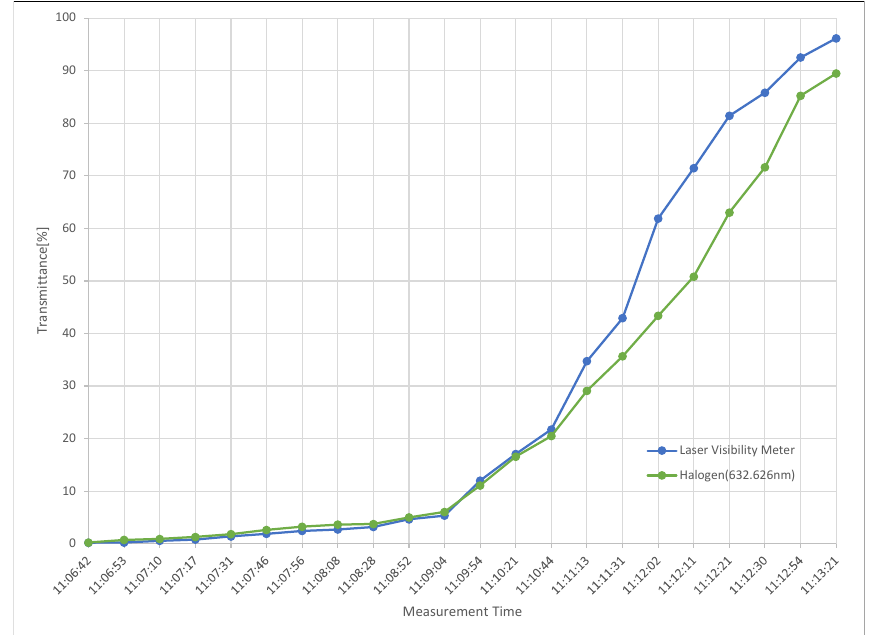
Figure 10. The measured transmittance obtained in the halogen transmittance experiment at 632.8 nm wavelength used by the laser visibility meter and the laser visibility